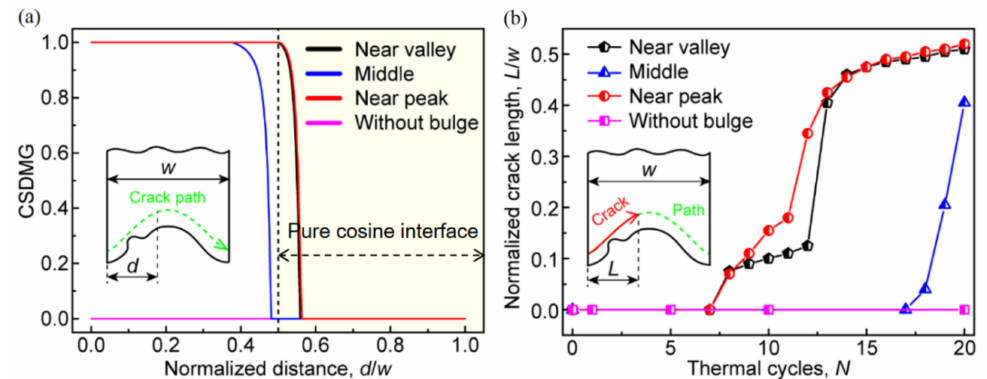
Figure 12. Effects of the location of one bulge on the ceramic cracking: ( a ) the CSDMG along the cracking path in the ceramic layer ( N = 20, at room temperature) and ( b ) variation of the total crack length with the thermal